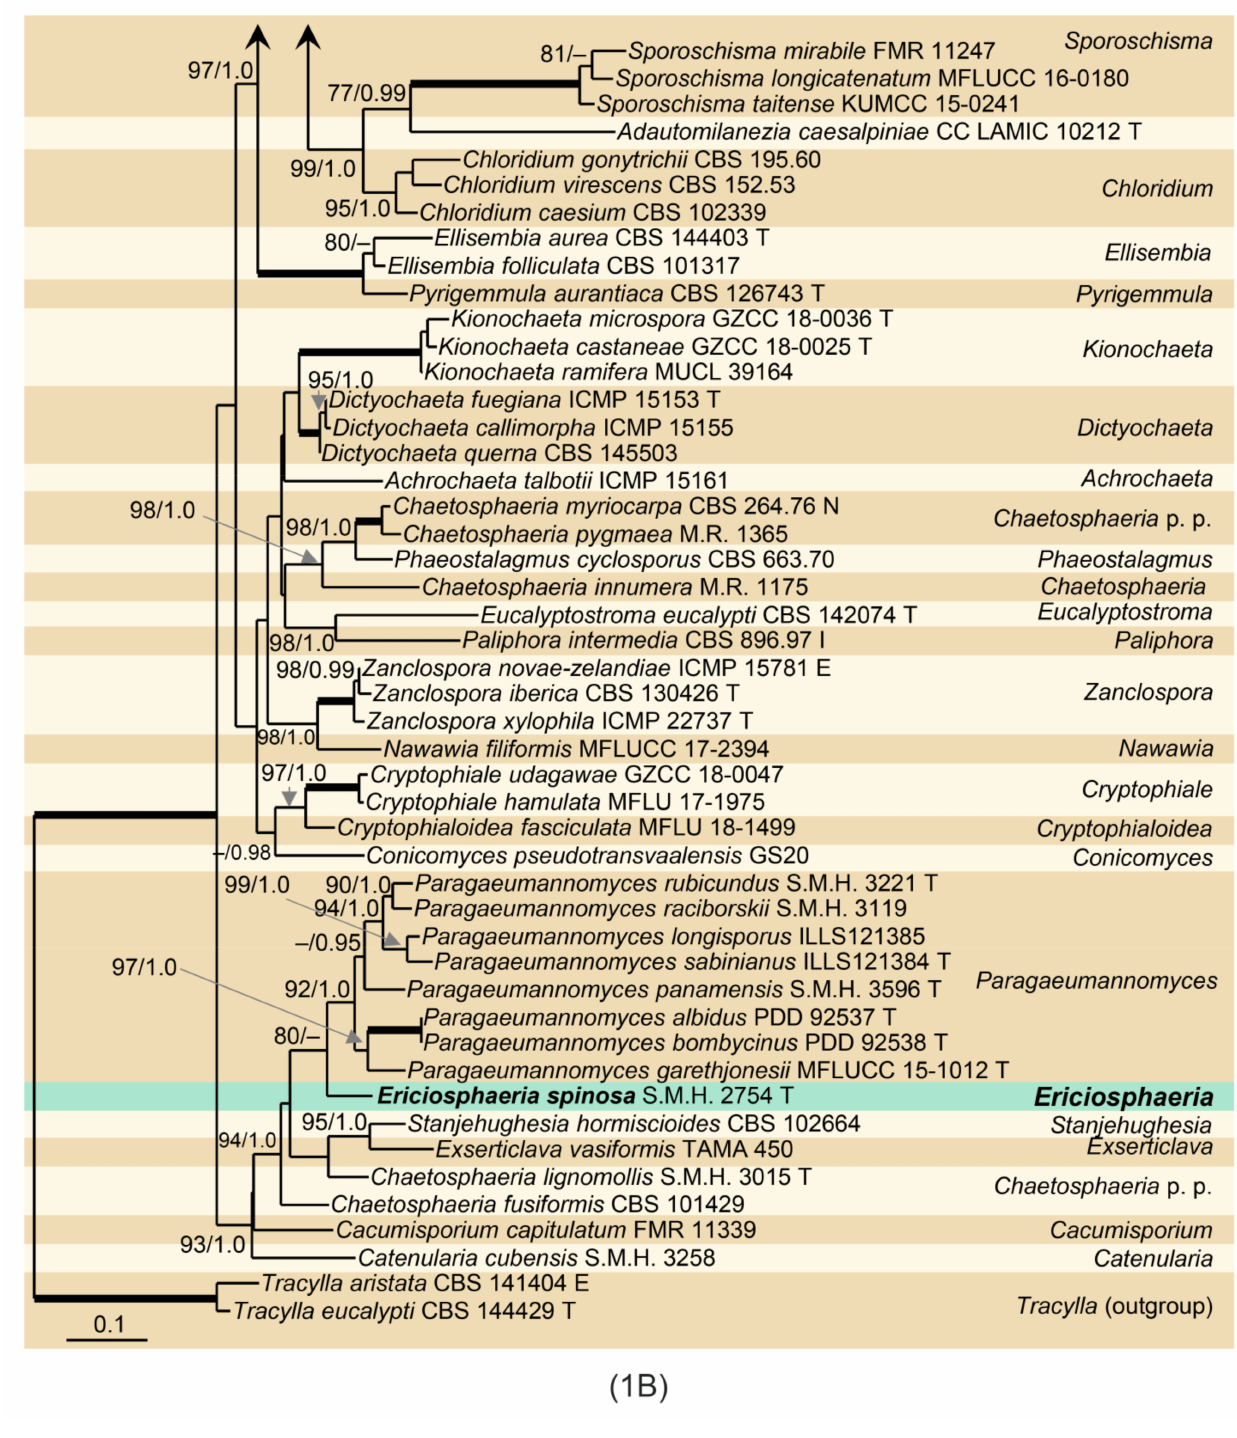
Figure 1. ( A ) Phylogenetic tree based on the combined ITS-28S rDNA sequences constructed by maximum likelihood (RAxML) of selected members of the Chaetosphaeriaceae. Species names given in bold and placed in green boxes are taxonomic novelties. T, E, I, N and P indicate ex-type, ex-epitype, ex-isotype, ex-neotype and ex-paratype strains; asterisk (*) indicates ex-type of Tainosphaeria obclavata (= Phialogeniculata guadalcanalensis ). Thickened branches indicate branch support with ML BS = 100% and PP values = 1.0. Branch support of nodes ≥ 75% ML and ≥ 0.95 PP is indicated above or below branches. ( B ) Phylogenetic tree based on the combined ITS-28S rDNA sequences of the Chaetosphaeriaceae (continued). For legend refer to ( A ). Abbreviation: p.p. after a genus name (pro